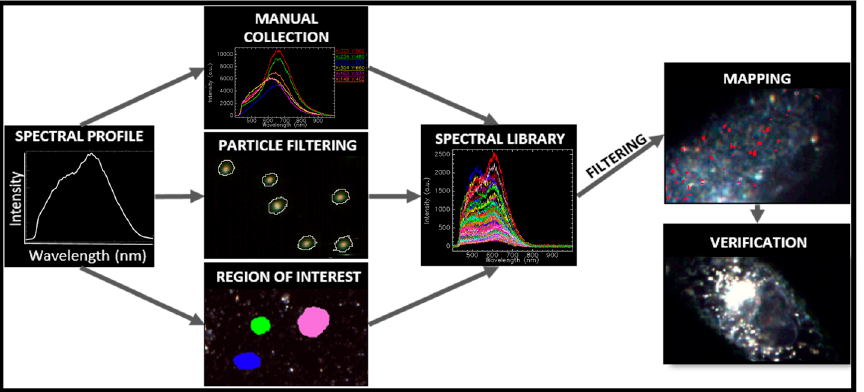
Figure 2. Workflow description of the data analysis and mapping. The spectral library can be generated either manually by individual selection of the acquired spectral profiles or through automated processes using software tools. The endmembers of the spectral library are tracked into unknown data cubes. This allows identifying the nanomaterials within biological matrixes. As a negative control for identification, cells unexposed to nanoparticles are mapped with the same spectral library [8].